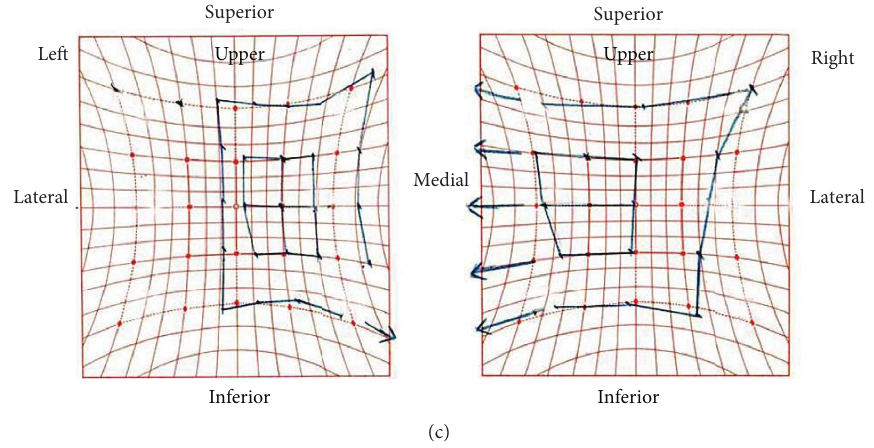
Figure 3: Noncontrast computed tomography imaging of the paranasal cavity and Hess screen test results at the emergency reexamination. CT images with (a) axial and (b) coronal views. The sphenoid sinus mucocele shows apparent growth, with increased impingement on the left superior orbital fissure (white arrow). (c) The Hess screen test confirms a disturbance in the left eye abduction and overaction in the right eye